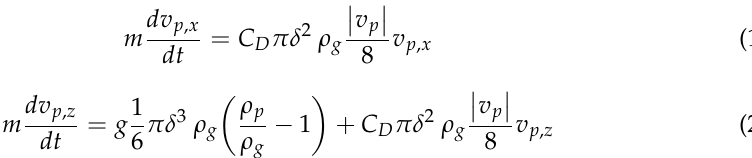
Figure 2. Particle size distribution of emitted DEHS aerosol. 𝛿 is the diameter of the particles.